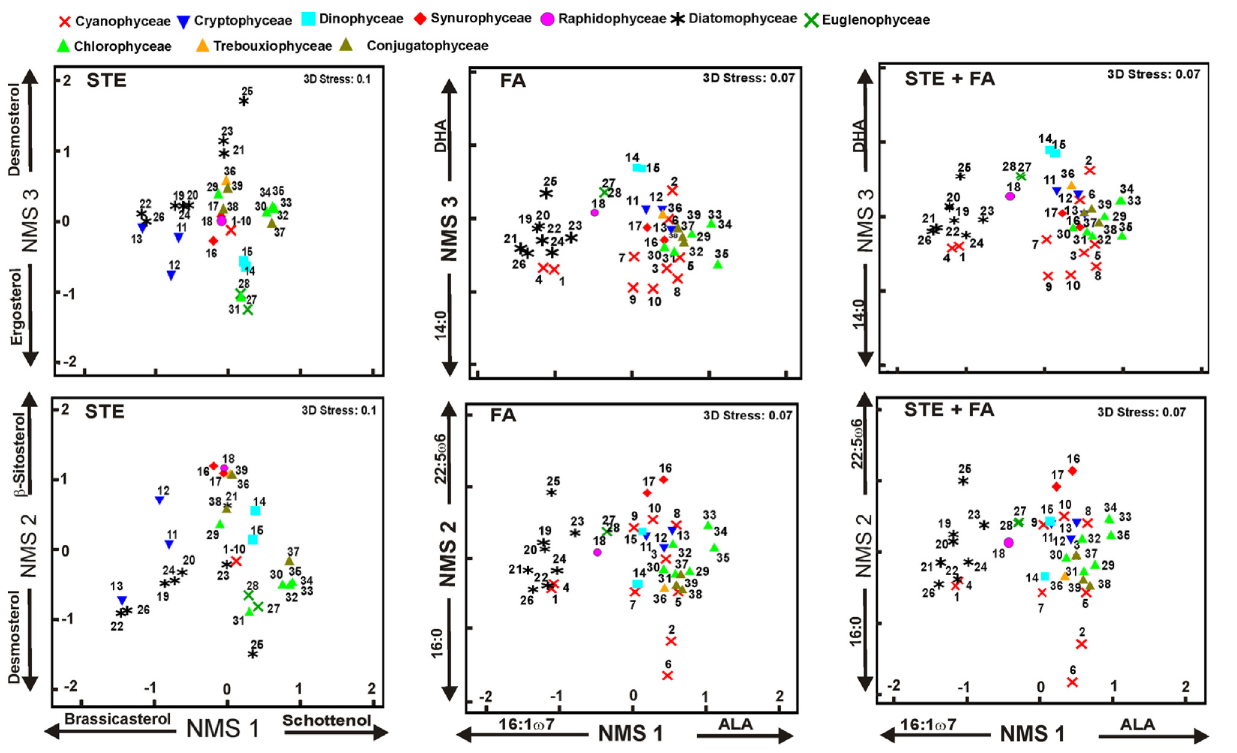
percentage decreased 20% when Cyanophyceae were included in the fatty acid or the combined data ( Table 4 ). While fatty acid profiles of phytoplankton are characteristic at class level, phytoplankton